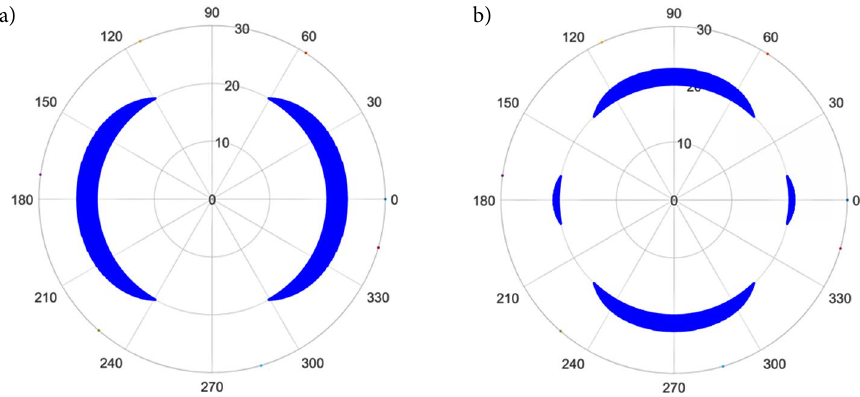
Figure 15. Failure contour for the reverse faulting stress regime: a) a = 0°, i = 0°; b) a = 90°, i